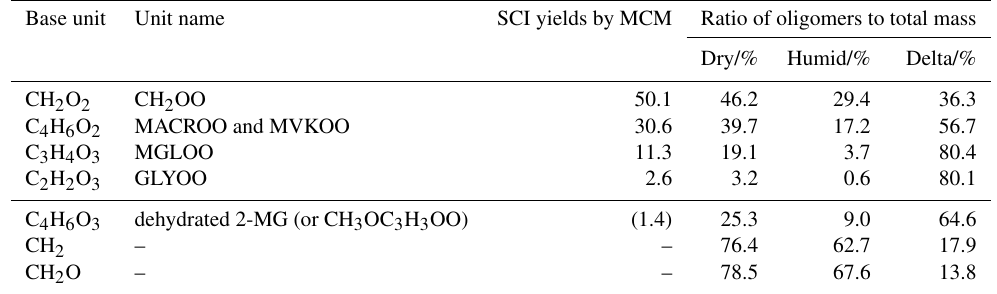
Table 2. List of major base units and their corresponding ratios of oligomers to total mass from SOA in isoprene-NO 2 irradiations. Base unit Unit name SCI yields by MCM